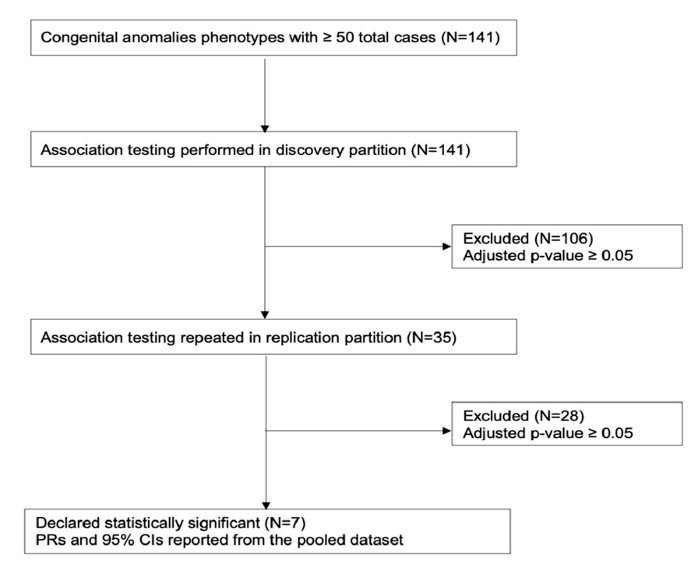
Figure 1. Overview of association testing methodology and phenotypes included at each stage of analysis.